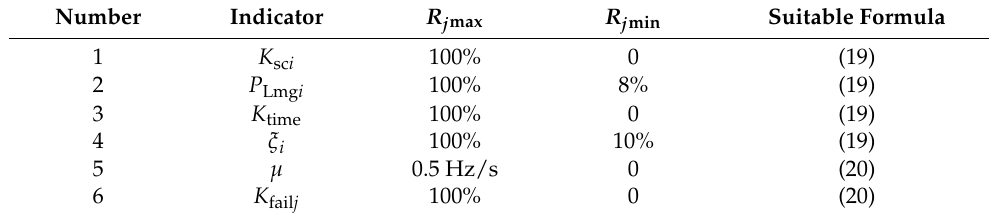
Table 1. Reference values for the